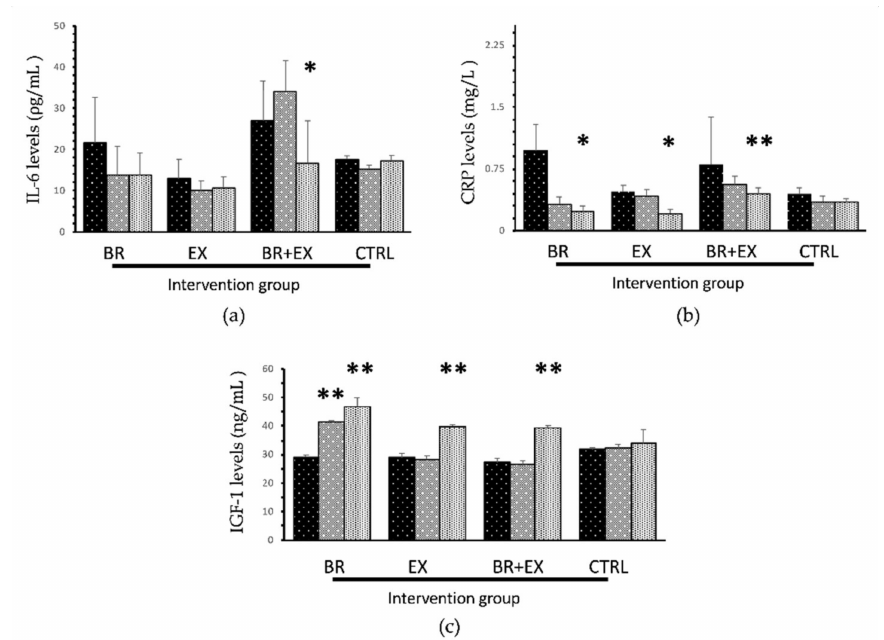
Figure 2. Changes in aging biomarkers in all 4 di ff erent intervention groups during the 24-week intervention period: ( a ) Interleukin-6 levels; ( b ) C-reactive protein levels; ( c ) Insulin-like growth factor-1 levels (data were expressed as mean ± SE, BR = Black rice germ and bran alone group, EX = Exercise alone group, BR + EX = Combined group and CTRL = Control group) * p < 0.05, ** p < 0.001 vs. baseline with statistical significance using repeated measured ANOVA.